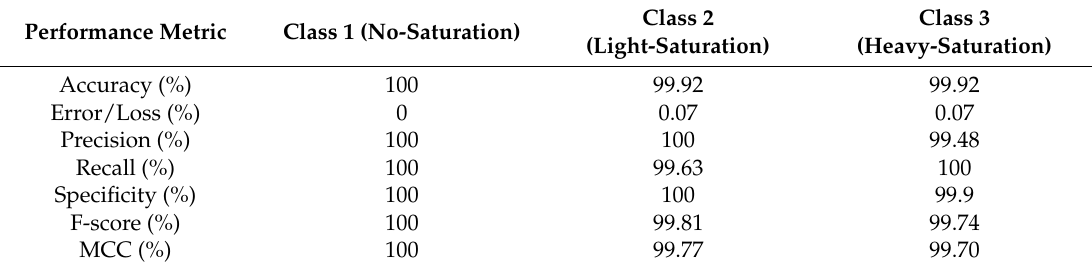
Table 10. Performance of proposed method on the test dataset. Different performance metrics were calculated to validate the performance of on each